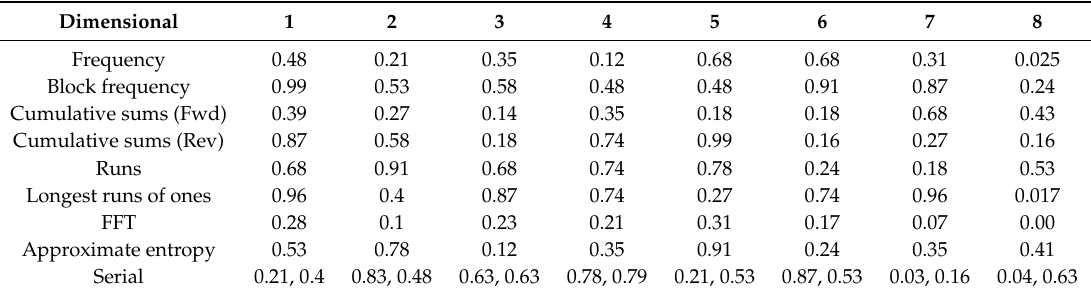
Table 2. NIST test results for generating keys under different dimensions.